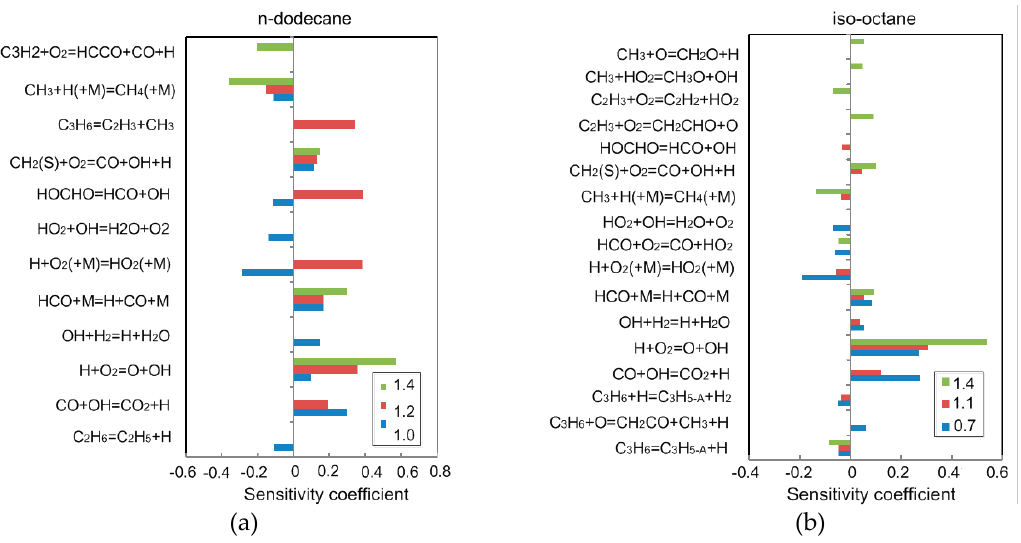
Figure 11. Sensitivity coefficients of laminar flame speed at T=400K and P=0.1MPa with (a) n-dodecane and (b) iso-octane